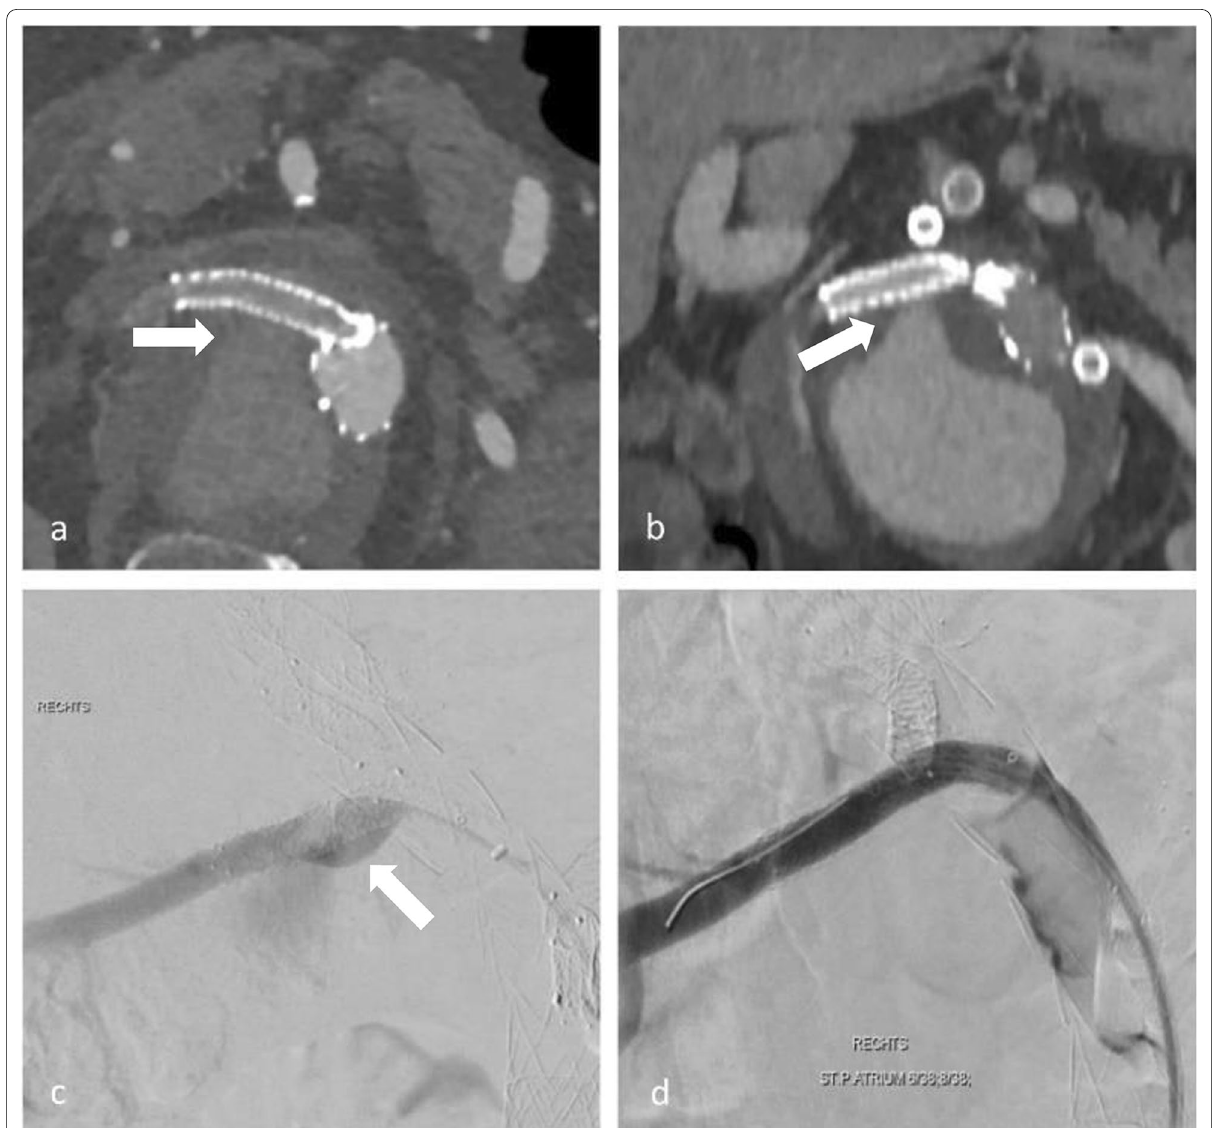
Fig. 5 Detection of an unspecified endoleak directly adjacent to the right renal BSG in arterial and venous CTA ( a , b ), confirmed to originate from a membrane disruption via angiography ( c ) and after successful religning ( d